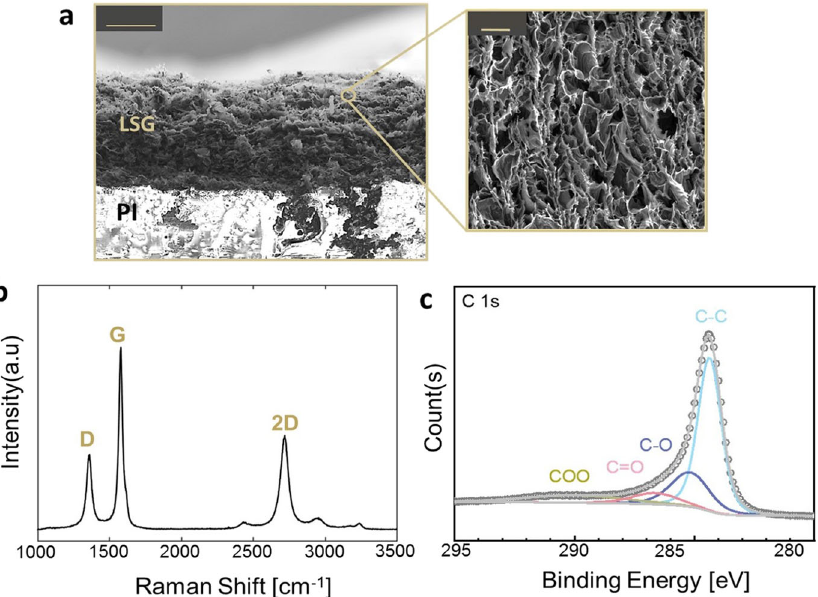
Fig. 1 Laser-scribed graphene (LSG) characterization. a Cross ‐ sectional SEM images of porous graphene structures on PI after laser irradiation (scale bar: 30 µm). The inset with a higher magni fi cation shows randomly arranged and interconnected graphene fl akes (scale bar: 5 µm). b Raman spectrum of LSG. c High ‐ resolution XPS spectrum of the C1s region of LSG.